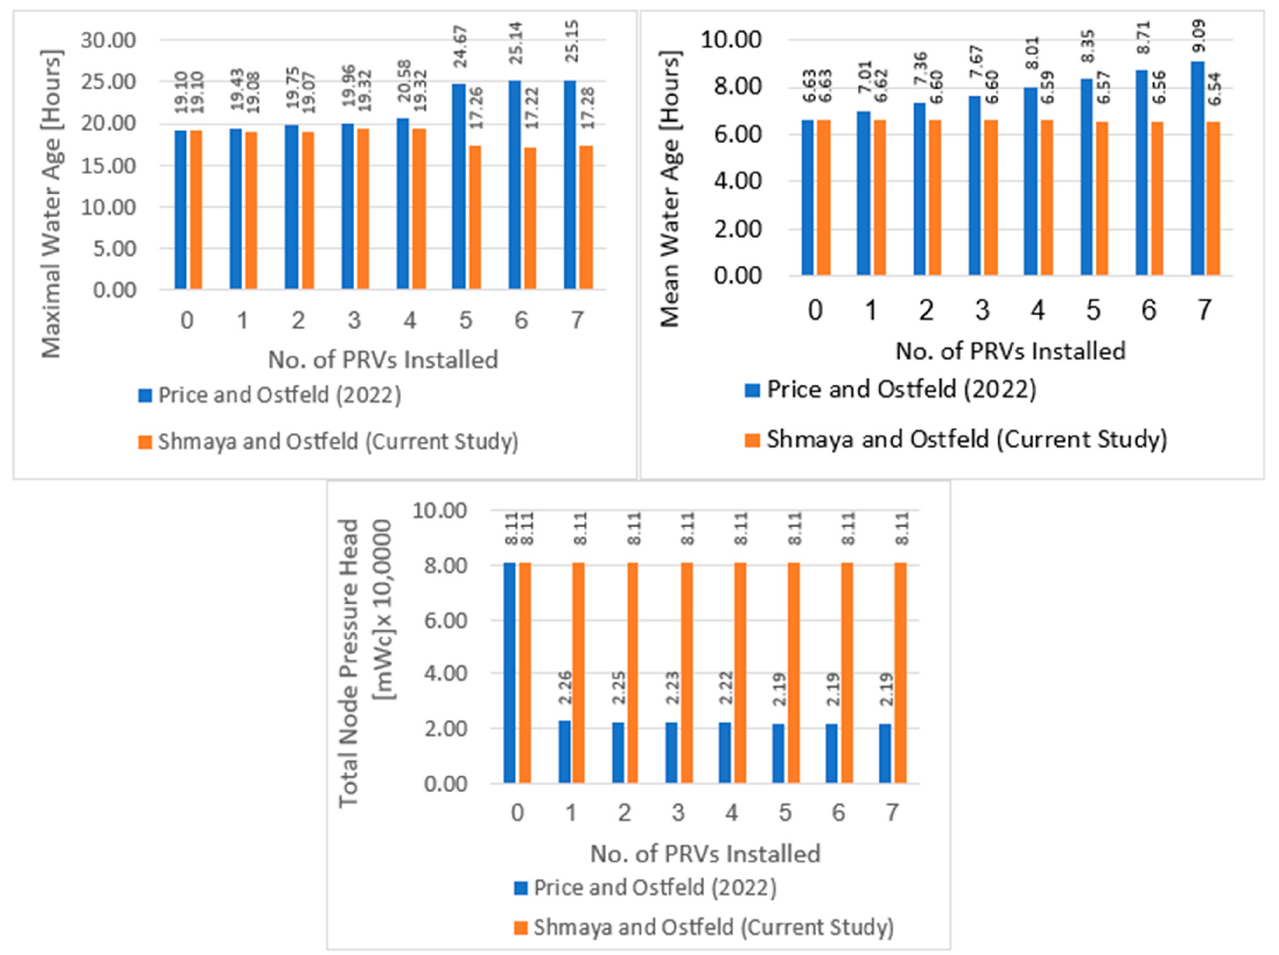
Figure 8. Maximal water age ( top left ), mean water age ( top right ) and total node pressure ( bottom ) after placing each one of the seven PRVs on the Fossolo network using both methods.